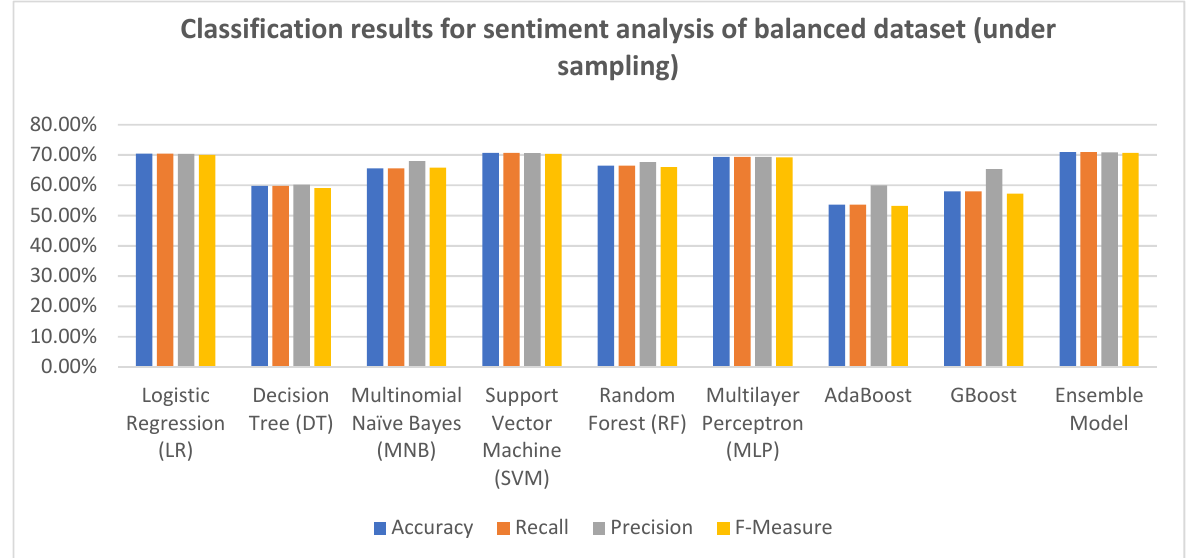
Figure 5. Classification results for sentiment analysis of balanced dataset (undersampling).